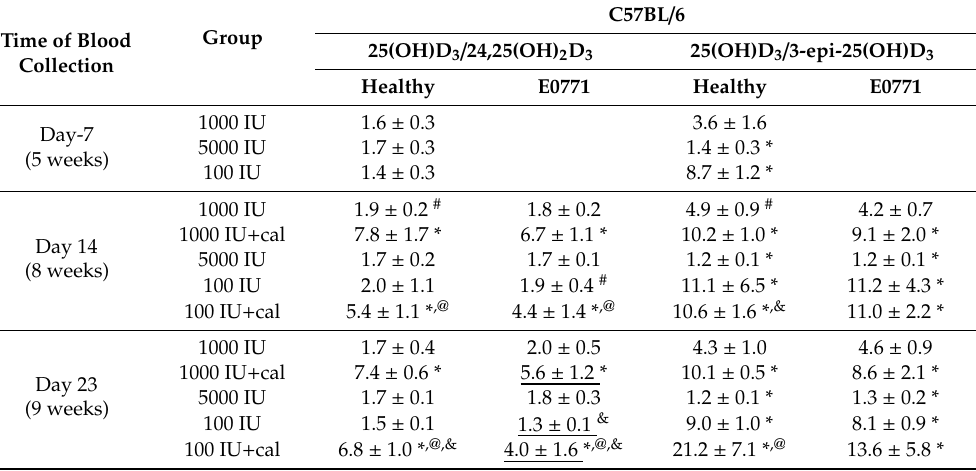
Table 3. Ratio of 25(OH)D 3 to 24,25(OH) 2 D 3 and to 3-epi-25(OH)D 3 in C57BL / 6